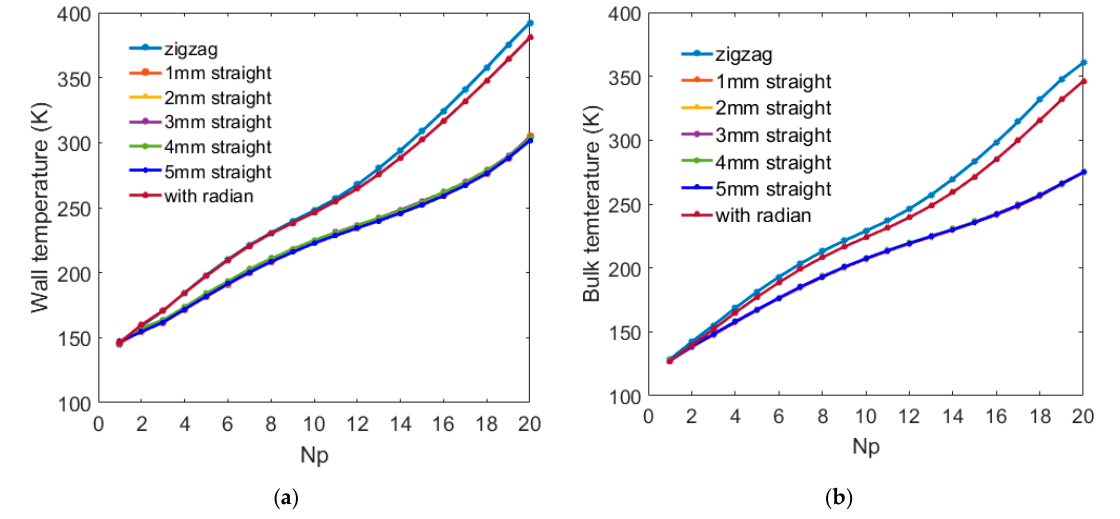
Figure 8. ( a ) Wall temperature and ( b ) LNG bulk temperature for different channel shapes.